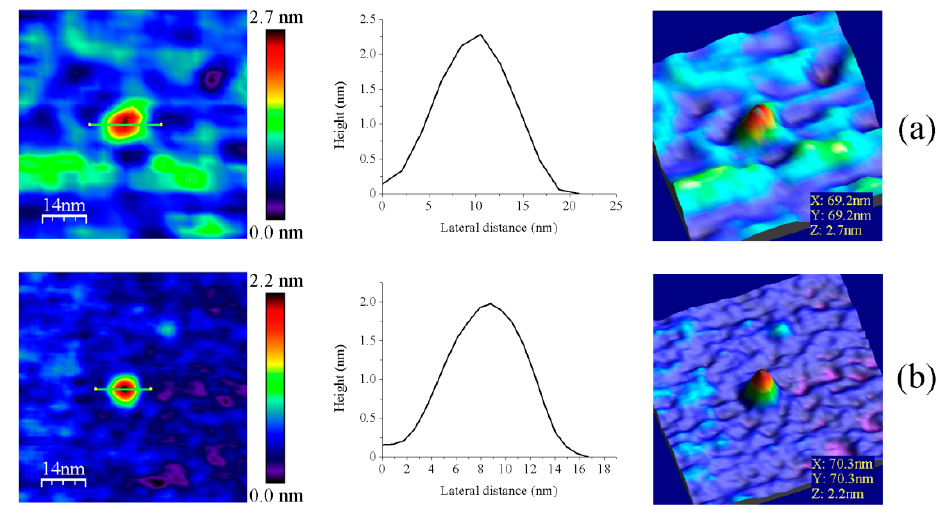
Figure 6. Representative main features as visualized by AFM of ( a ) GvFdx1 and ( b ) GvTrxm. Samples measured in PBS pH 6.0. Topography images are shown in 2D (left panels) and 3D (right panels), while the height profiles (central panels) correspond to the green lines traced on the 2D images. Scan sizes for all images are 70 nm × 70 nm.